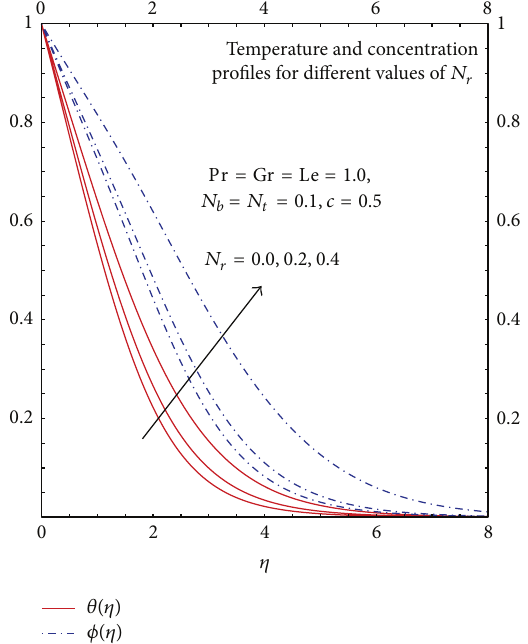
Figure 9: Graphs of 𝜃(𝜂) and 𝜙(𝜂) for different 𝑁 𝑟